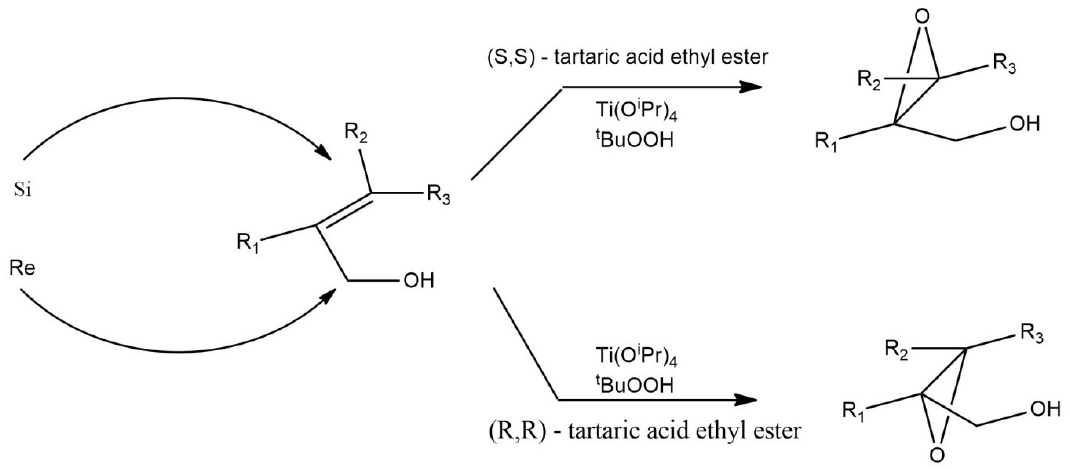
Figure 2. Sharpless system diagram for asymmetric olefin epoxidation [21].